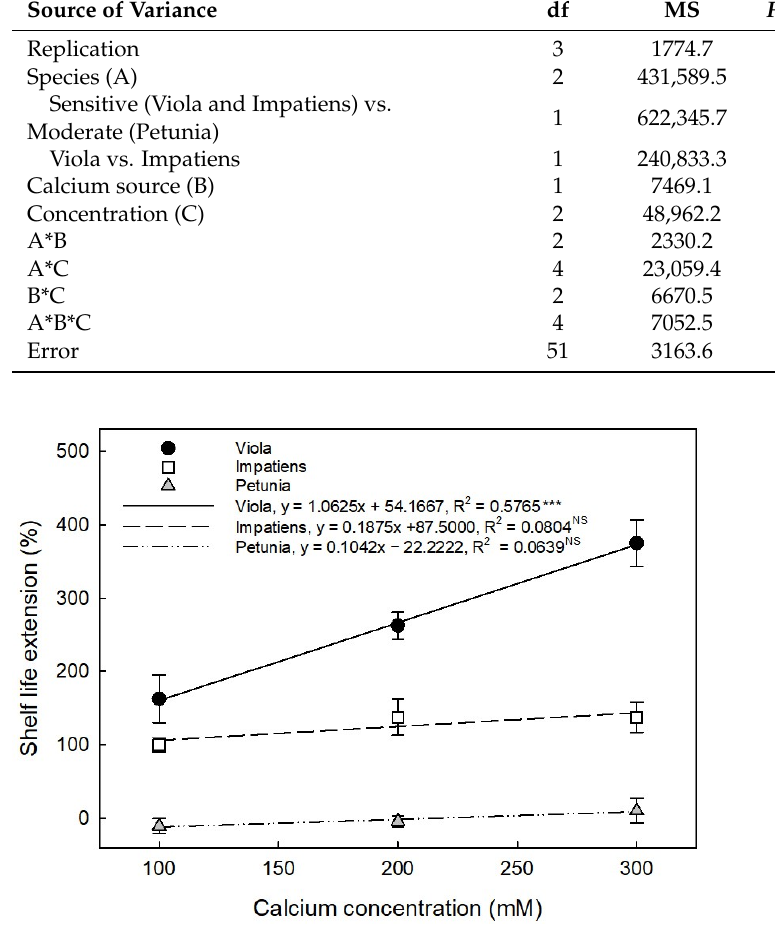
Figure 5. Influence of calcium concentration on shelf life extension of V. cornuta (viola), I. walleriana (impatiens), and P. grandiflora (petunia) in pre-drench application. Each data point represents the mean of shelf life extension from CaCl 2 and Ca(NO 3 ) 2 , but the analysis was performed with all data (n = 8). Bars represent standard error. NS, nonsignificant; ***, significant at P ≤ 0.001.